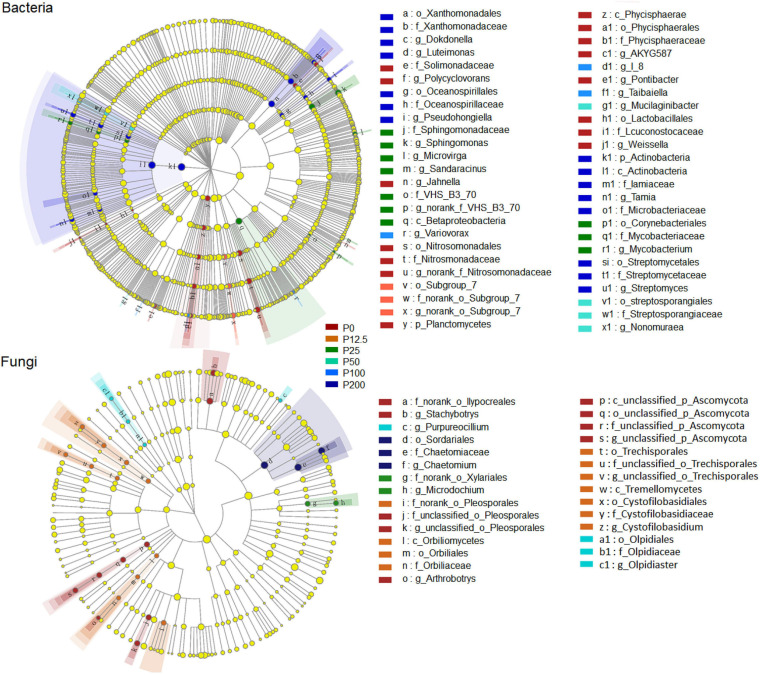
A linear discriminant analysis effect size (LEfSe) method identifies the significantly different abundant taxa of bacteria and fungi with linear discriminant analysis (LDA) score higher than 3.0. Circles represent phylogenetic levels from kingdom to genus. The taxa with significantly different abundances among P0, P12.5, P25, P50, P100, and P200 P fertilization levels are represented by colored dots. Abbreviations: P0, P12.5, P25, P50, P100, and P200 represent 0, 12.5, 25, 50, 100, and 200 kg P ha–1, respectively.